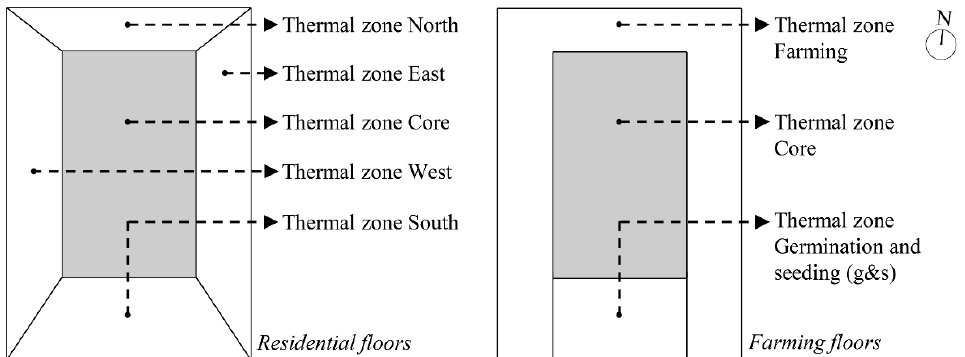
Figure 5. Thermal zones of energy model in residential and farming floors.